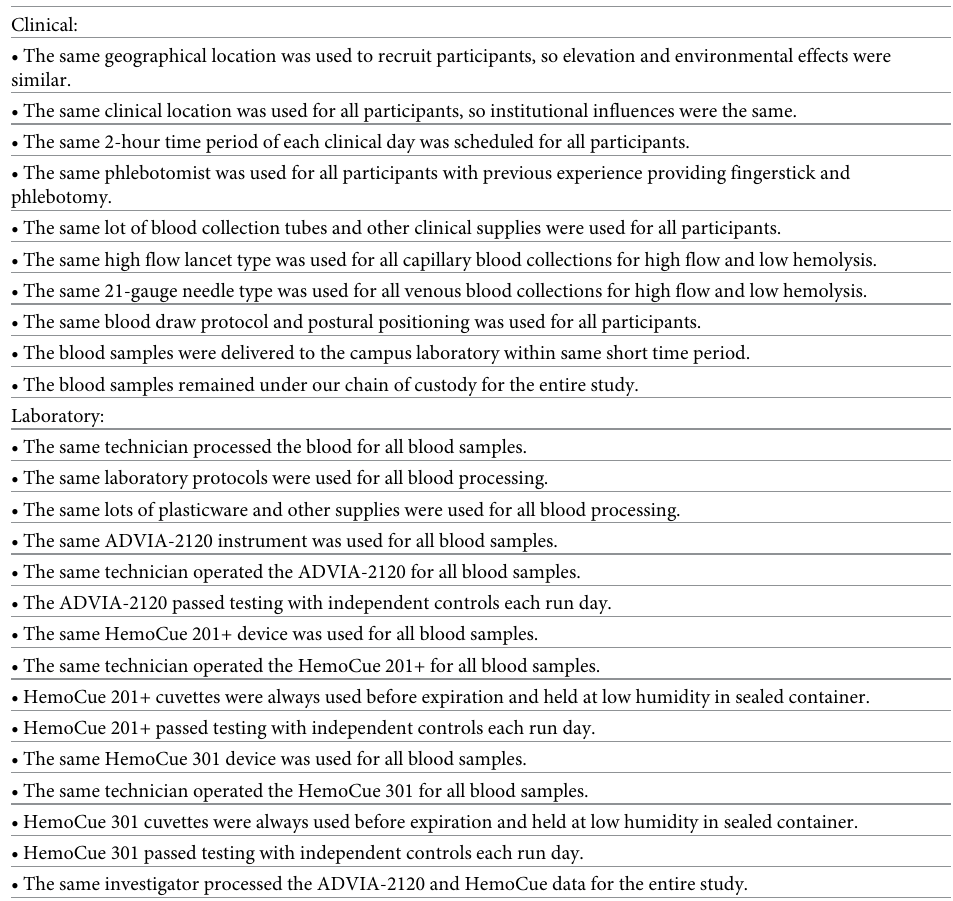
Table 1. Analytical variables controlled in this